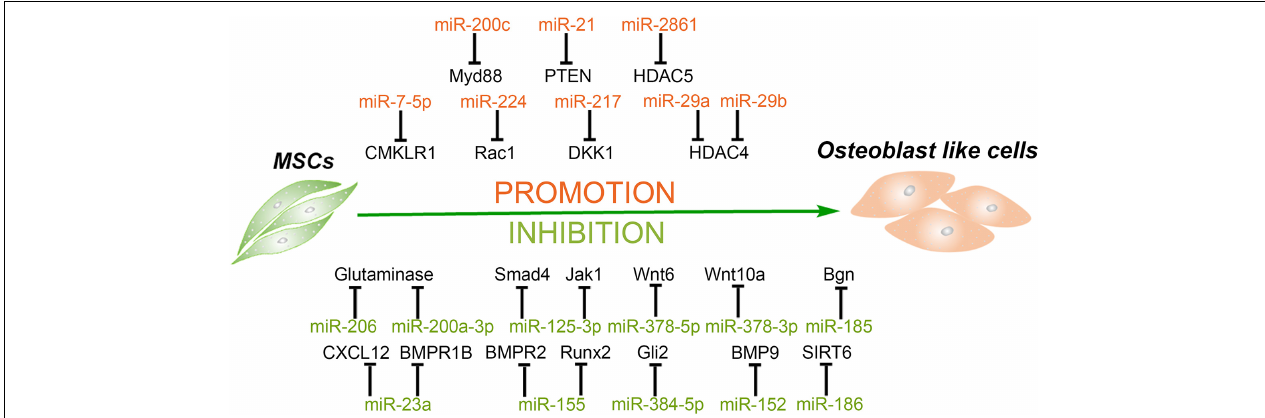
FIGURE 2 | MiRNAs mediate the osteogenic differentiation of mesenchymal stem cells. MiRNAs promote the osteogenesis of MSCs via silencing the expression of HDAC4/5, CMKLR1, DKK1, Myd88, PTEN, etc. and in turn inhibit histone deacetylation, activation of Wnt/ β -catenin, and Akt signaling. Meanwhile, some miRNAs inhibit the osteogenesis of MSCs through targeting vital regulators, synergistic enhancer, or essential nutrients in this process, including BMPs, BMPRs, Gli2, SIRT6, glutamine, and so forth.